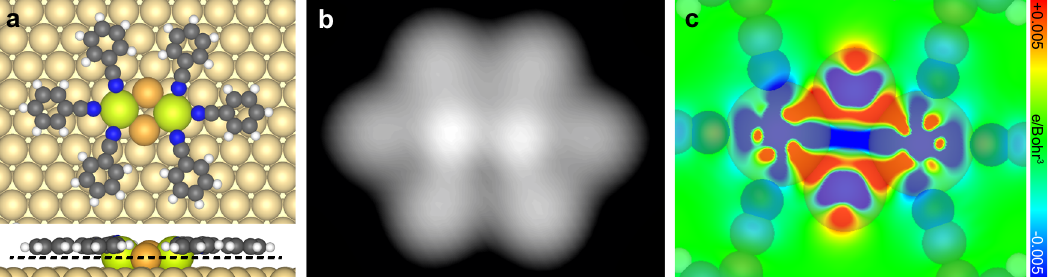
Fig. 5 Theoretical results of the Ce 2 Au 2 (CN) 6 structure. a DFT optimized models (upper: top view, lower: side view), b simulated STM image, and c cross-section of the differential electron density along the black dashed line in a of the Ce 2 Au 2 (CN) 6 motif on Au(111). Simpli fi ed molecular ligands are